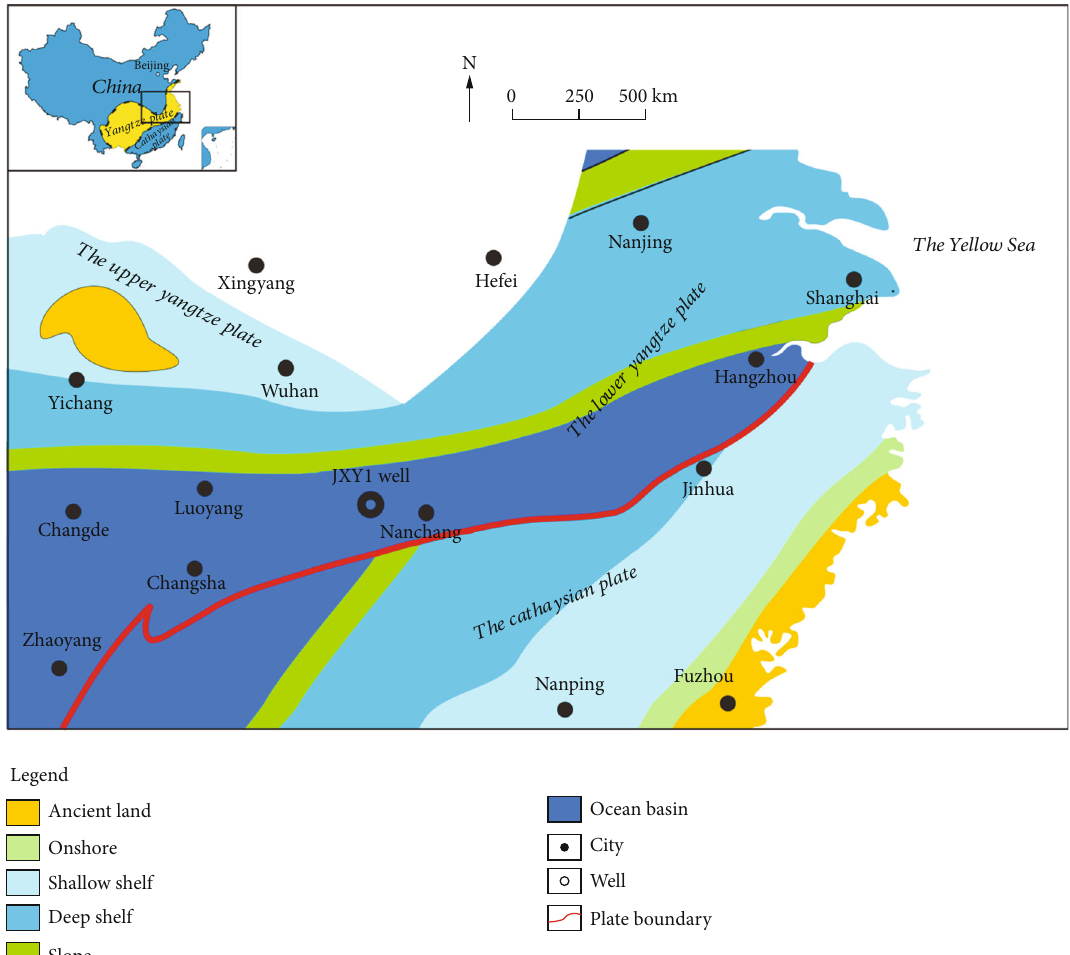
Figure 1: Regional sedimentary characteristics from the early Cambrian in the Lower Yangtze region of South China. (Well JXY1 is located in the Lower Yangtze region, close to the Yangtze plate and the Cathaysian plate.) Modi fi ed from references [24,